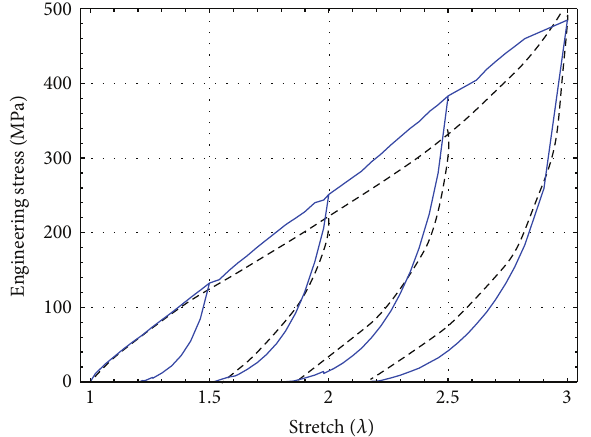
Figure 5: Engineering stress-stretch data for polydioxanone 2– 0 compared with theoretical predictions of the nonmonotonous amended average-stretch, full-network model for which 𝜇 = 126 MPa, 𝑁 = 6 , 𝑏 = 0.65 , and 𝐶 = 0.0035 MPa. The dashed black lines represent theoretical predictions, and the blue solid lines describe experimental data.